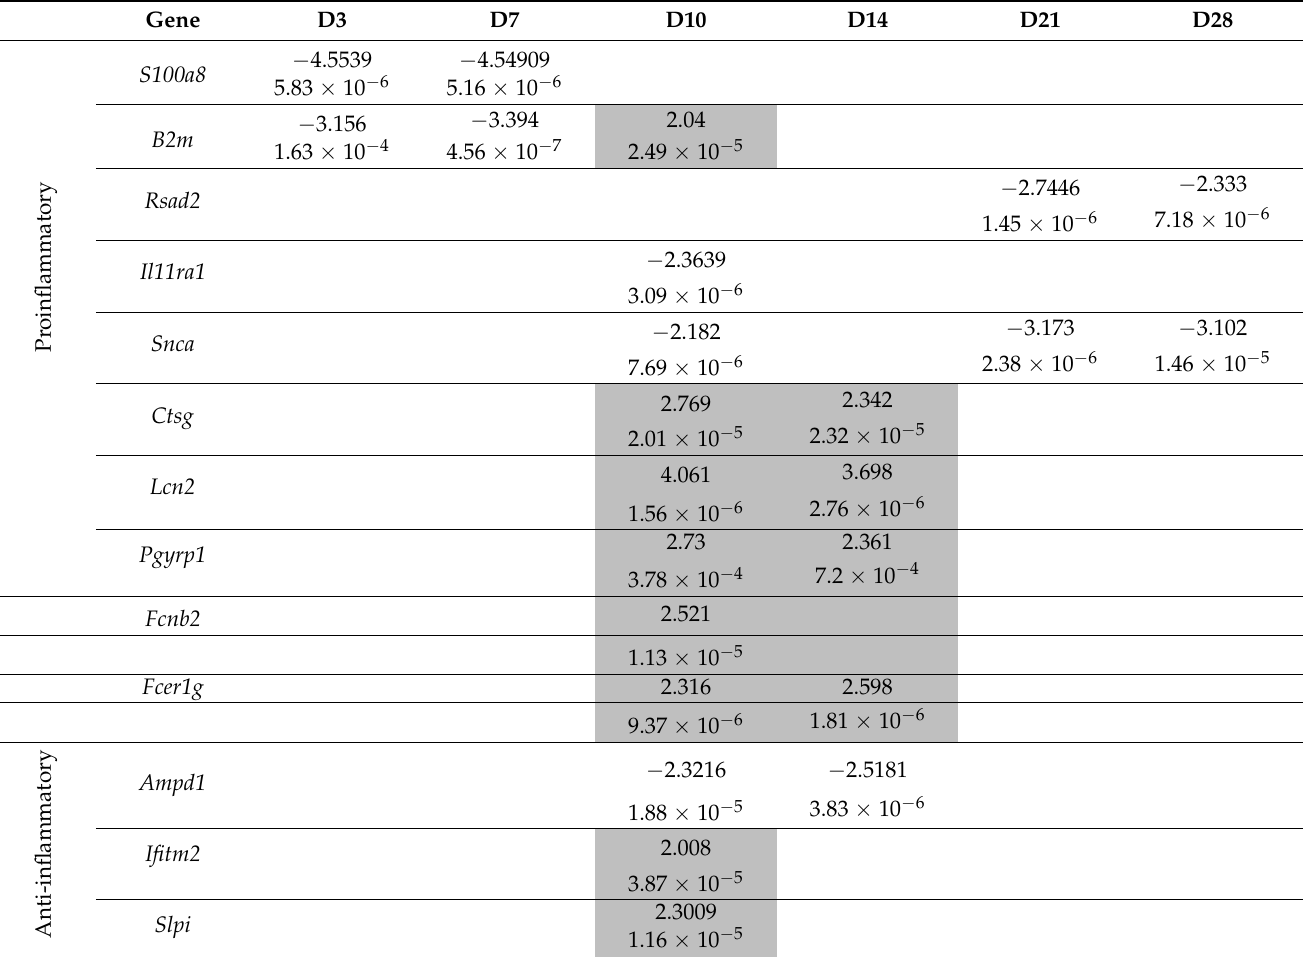
Table 1. List of differentially expressed pro- and anti-inflammatory genes and their FC and p -value (white background: downregulated and grey background: